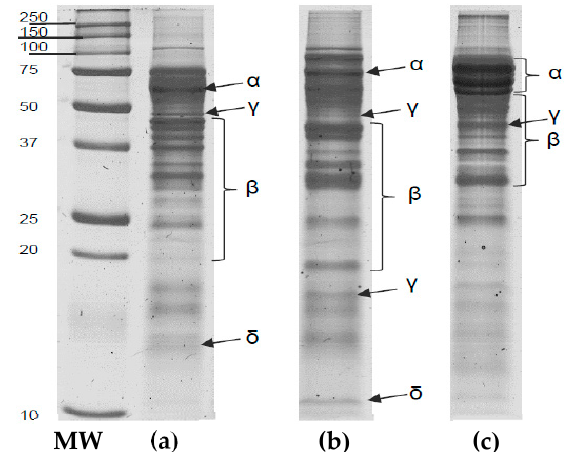
Figure 6. SDS-PAGE of three Lupinus varieties obtained in non-reducing conditions: ( a ) L. albus ; ( b ) L. angustifolius ; ( c ) L. mutabilis . MW- Molecular weight standard.